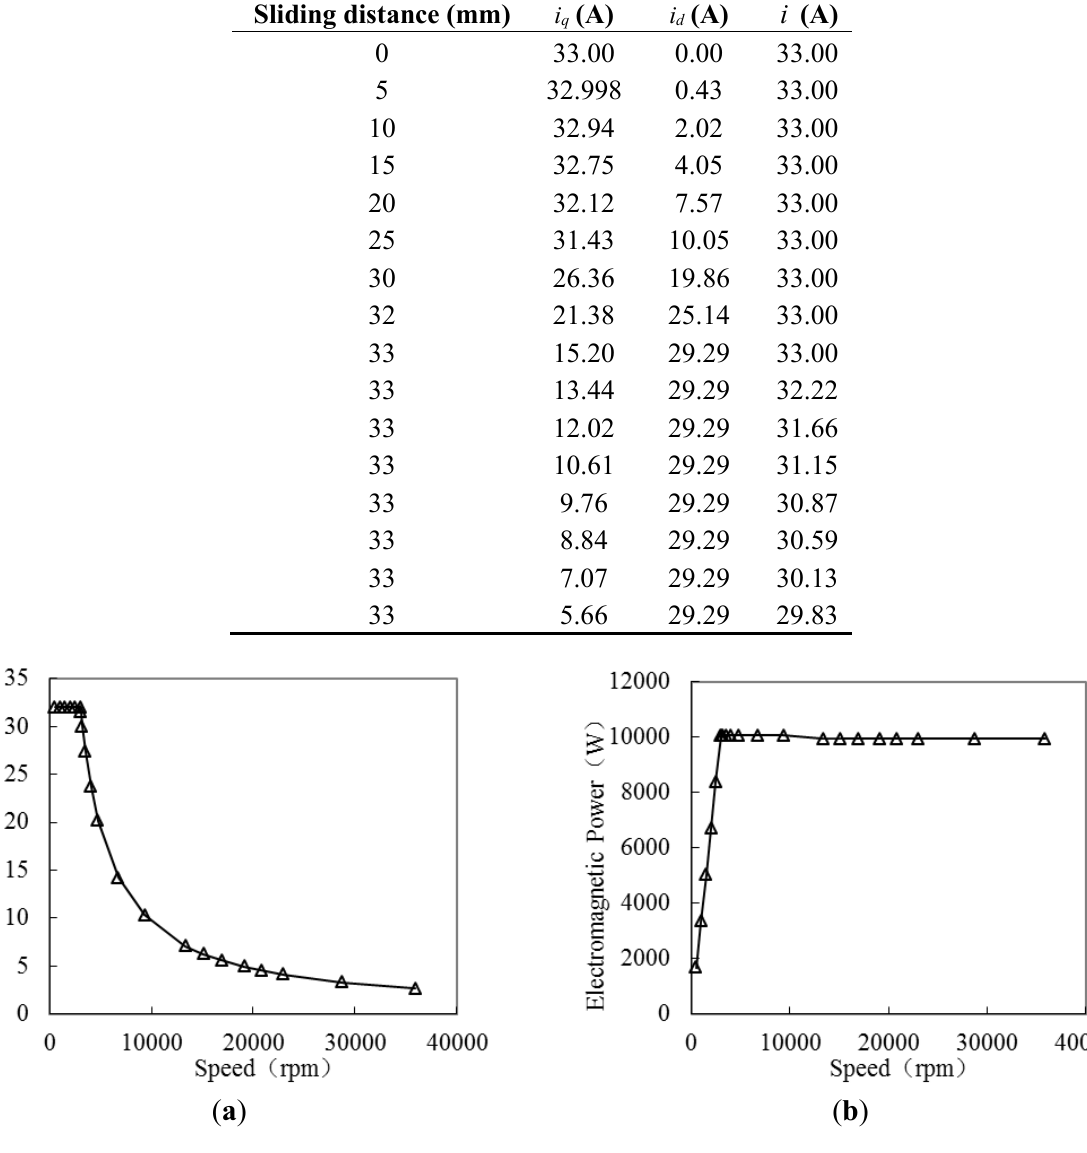
Figure 19. Field weakening capability with combination of mechanical and adjusting i i : ( a ) torque-speed and ( b ) q